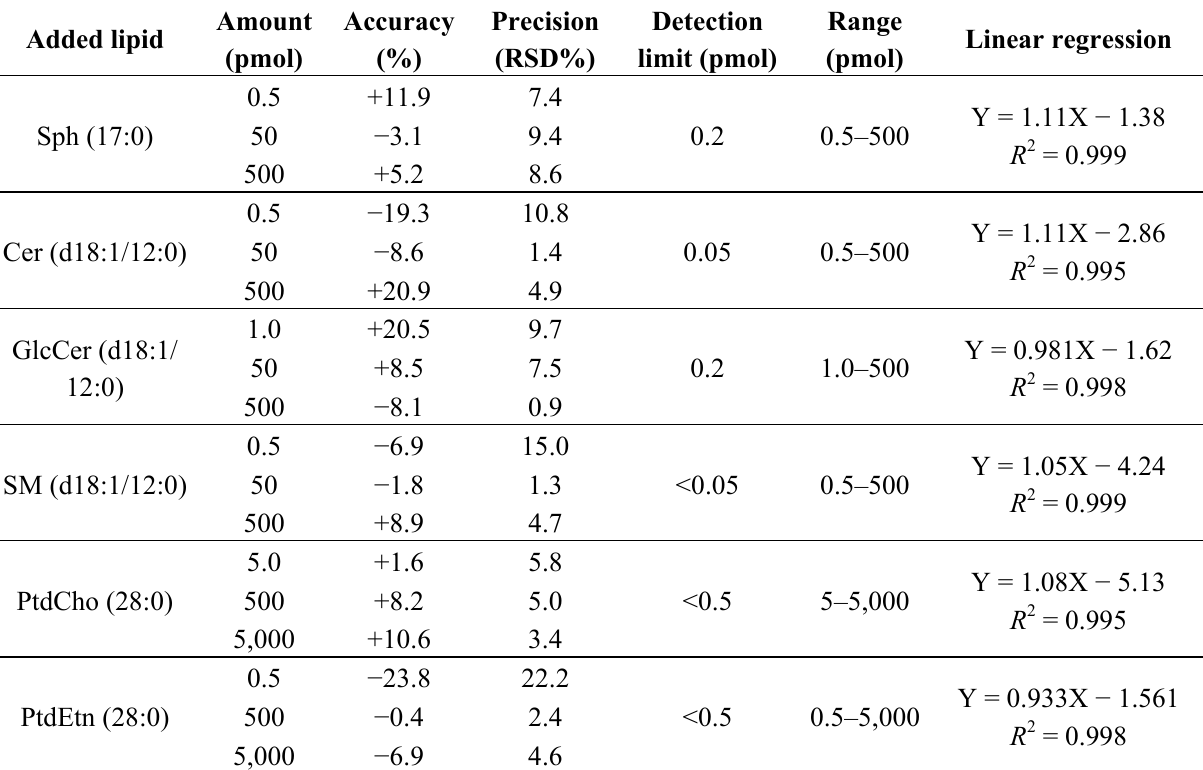
Table 3. Precision, accuracy and linearity of analyses of lipid standards added to the cell suspension. The linear regression equation was calculated from the log peak area for each eluted lipid versus the amount of standard added. Data were obtained from three or four measurements. The values are expressed as the mean ± SD. RSD, relative standard